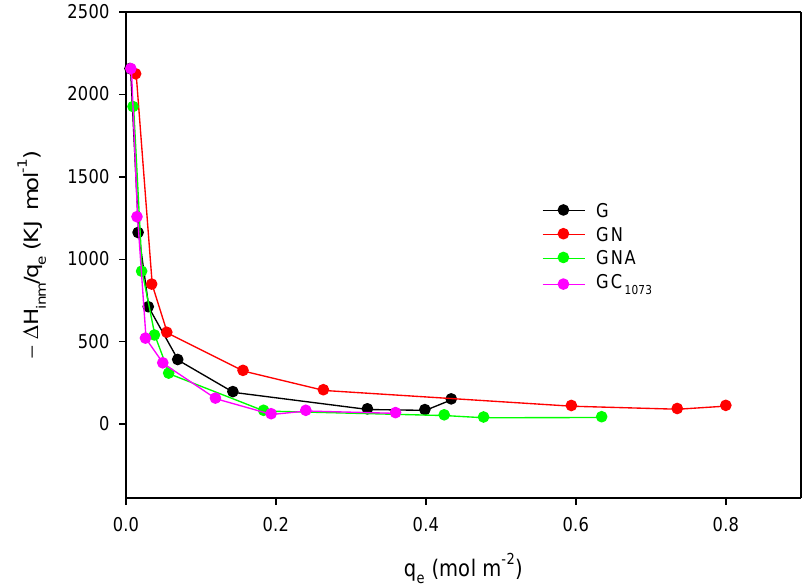
Figure 11. Relationship between the quantity of phenol adsorbed on the interface per unit of area and the immersion enthalpy per mole of phenol adsorbed on the interface for samples G, GN, GNA, and GC 1073 .